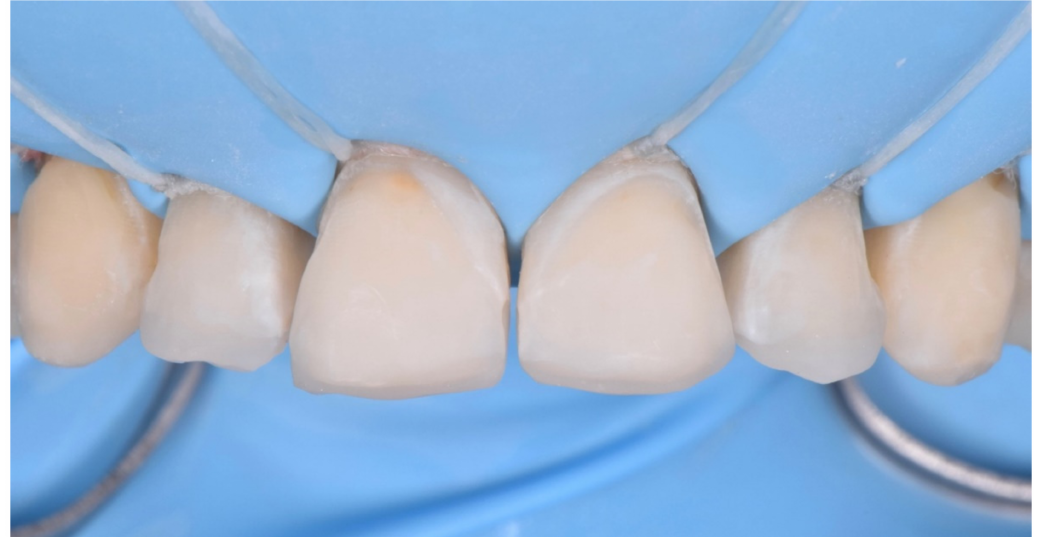
Figure 23. Rubber dam isolation with